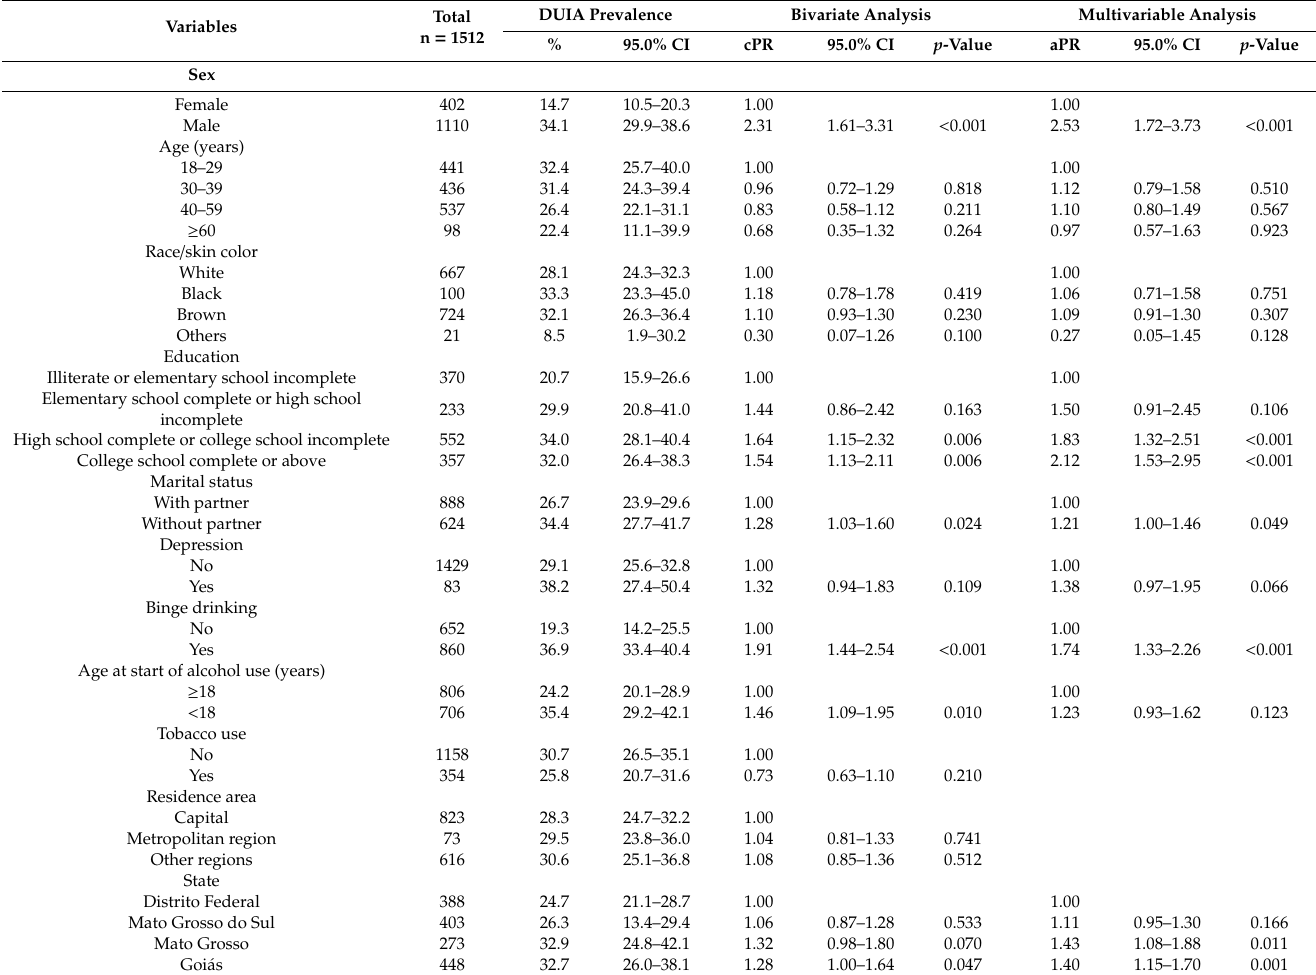
Table 4. Prevalence and Factors Associated with Driving Under the Influence of Alcohol in the Central-West Macroregion, Brazil. National Health Survey, 2013.